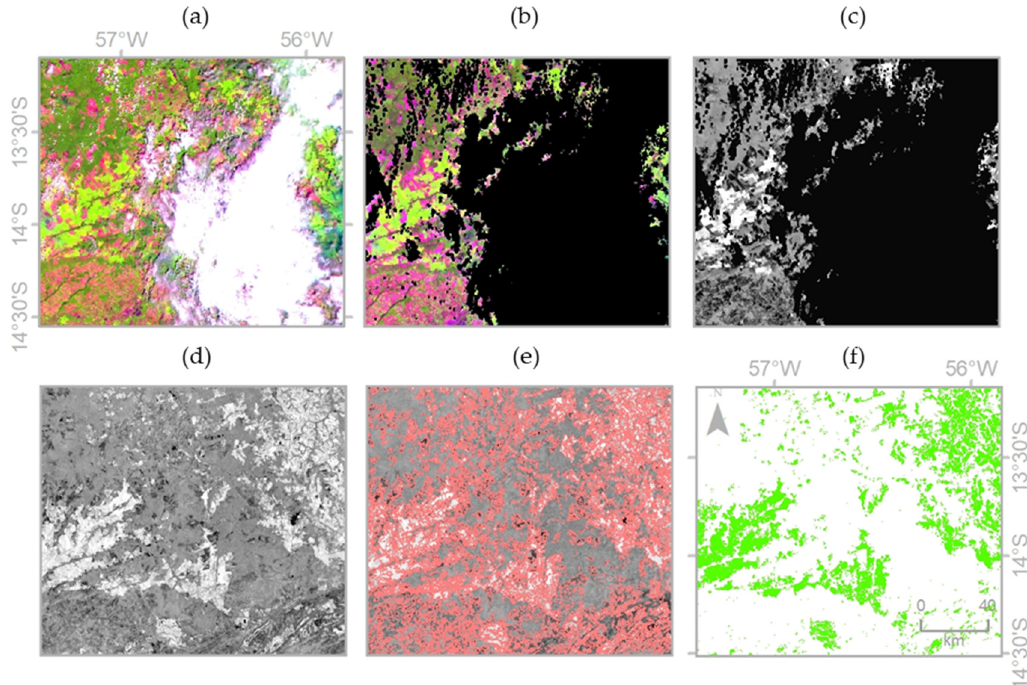
Figure 7. Representative process of the methodological flowchart. ( a ) Example of RGB color composites (bands SWIR, NIR, and red; date = 2015/12/11) of the PROBA-V 100 m, containing clouds; ( b ) PROBA-V 100 m after masked using SM dataset; ( c ) vegetation fraction image; ( d ) single maximum proportion value mosaic (year = 2015); ( e ) image segmentation results; and ( f ) croplands classification by ISOSEG technique.